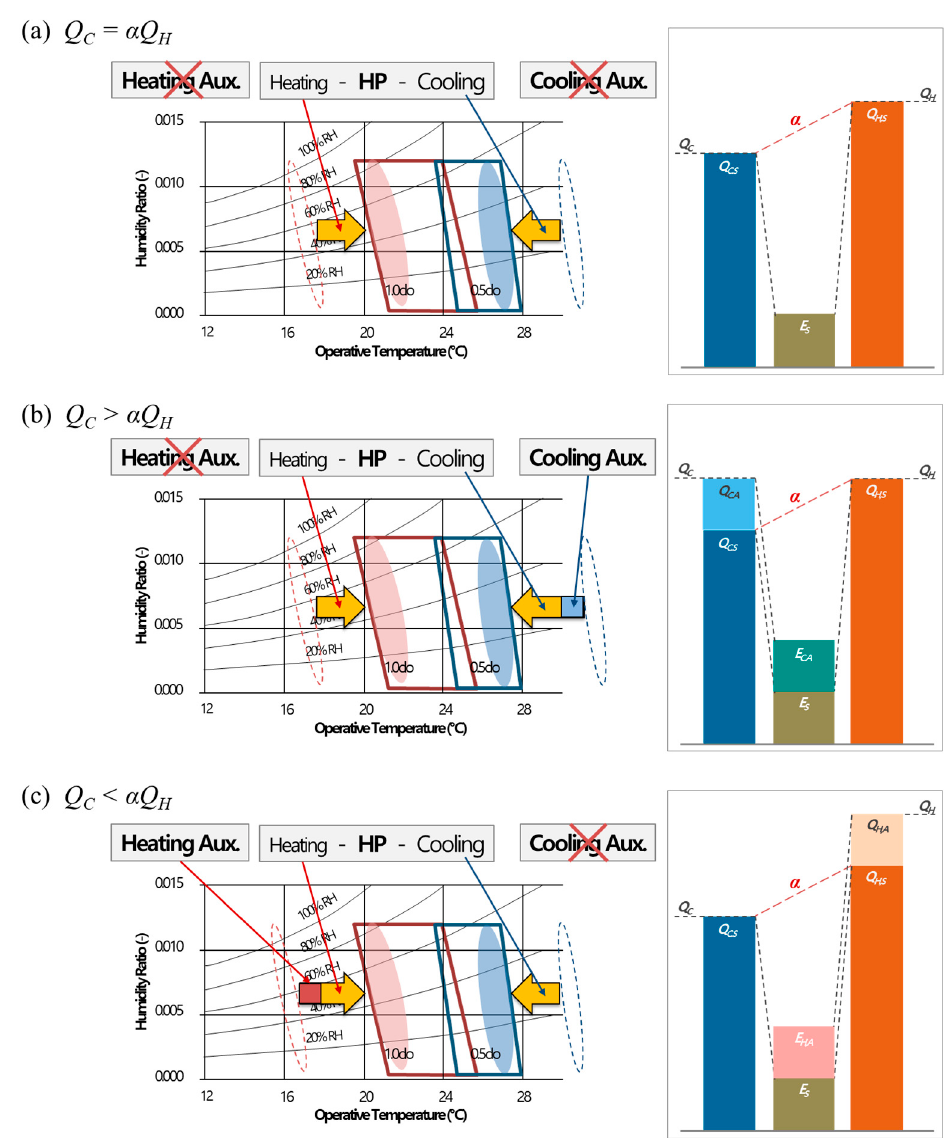
Figure 3. Energy consumption according to heating and cooling loads (general).